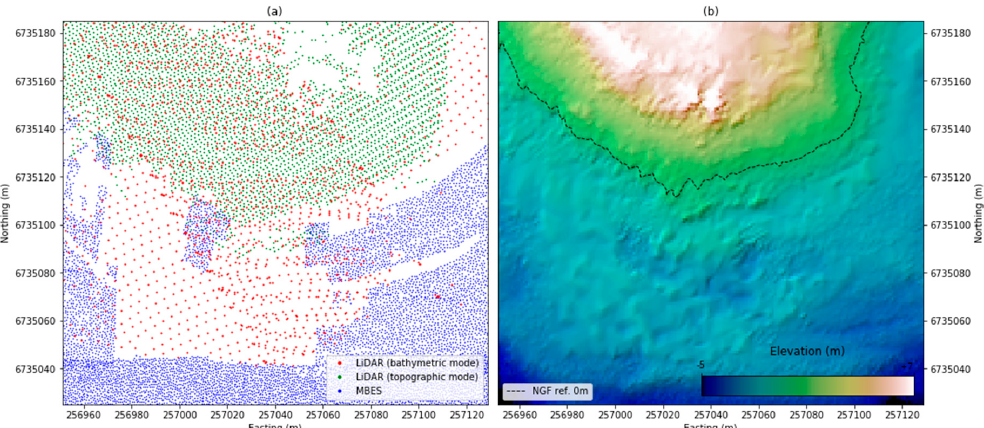
Figure 3. Litto3D bathymetric reference data ( a ) point cloud and ( b ) 1 m resolution raster.